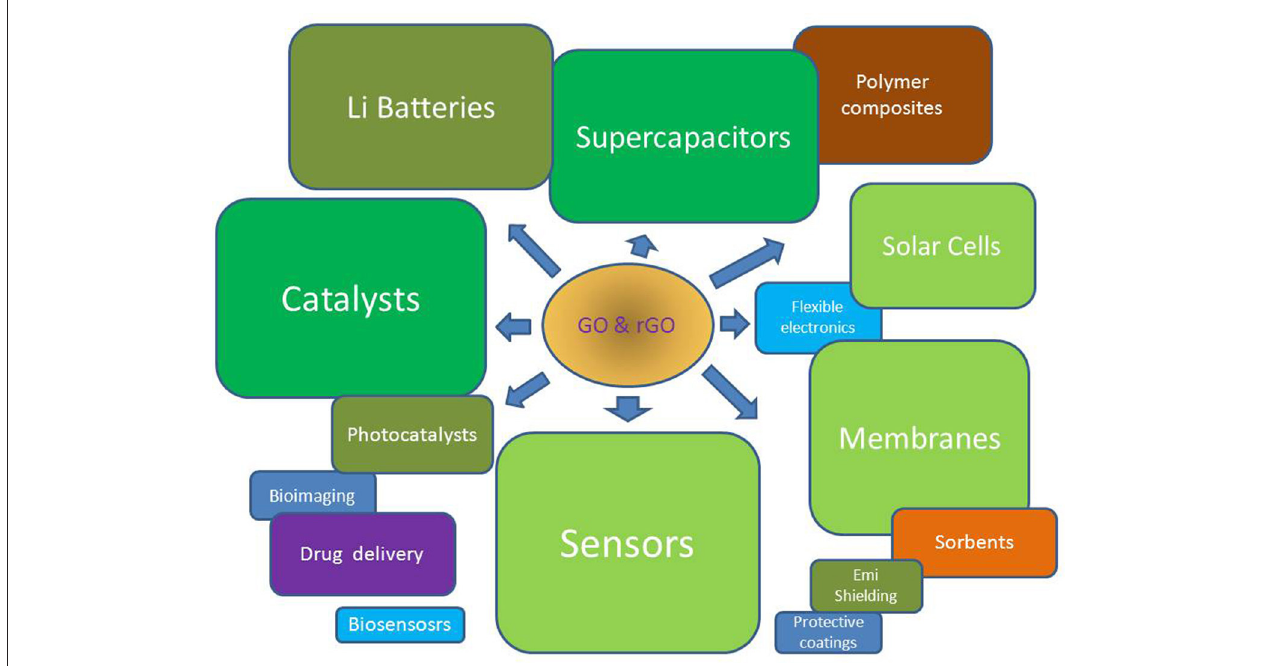
FIGURE 5 | Contemporary and prospective applications of GO and rGO. Size of blocks gives estimation of number of research publications for 2 recent years in corresponding areas. According to the Web of Science.